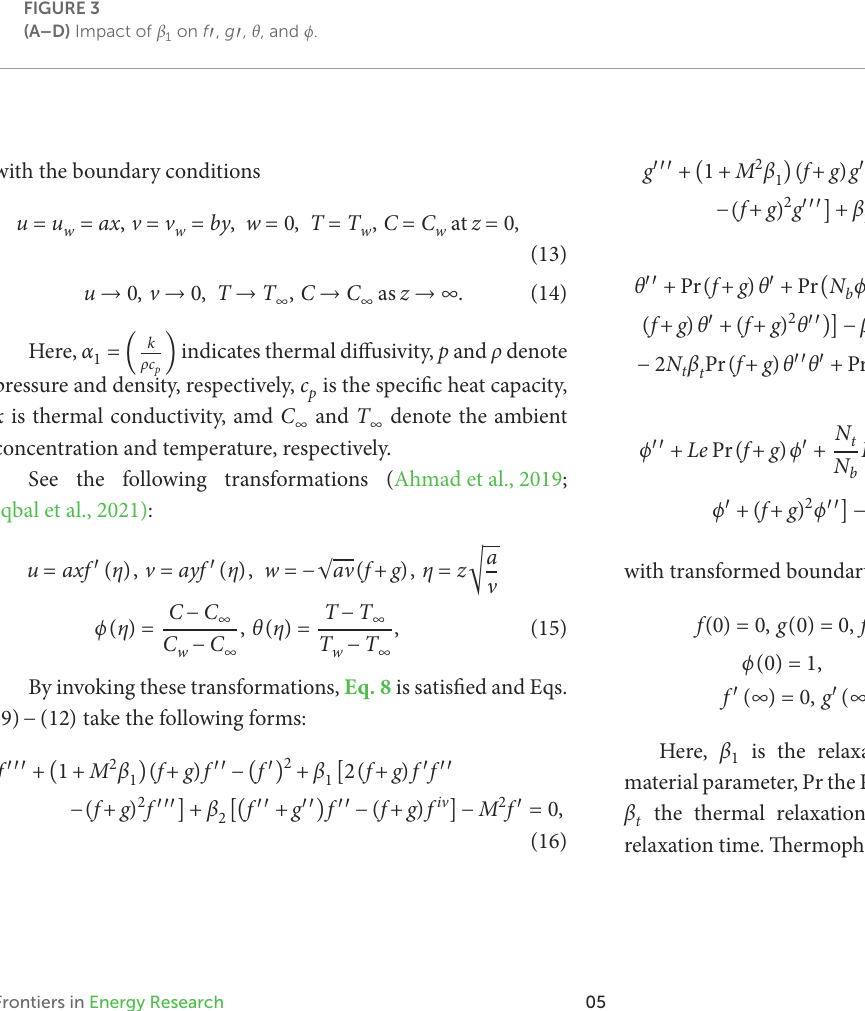
FIGURE 3 (A–D) Impact of β 1 on f ′ , g ′ , θ , and ϕ .